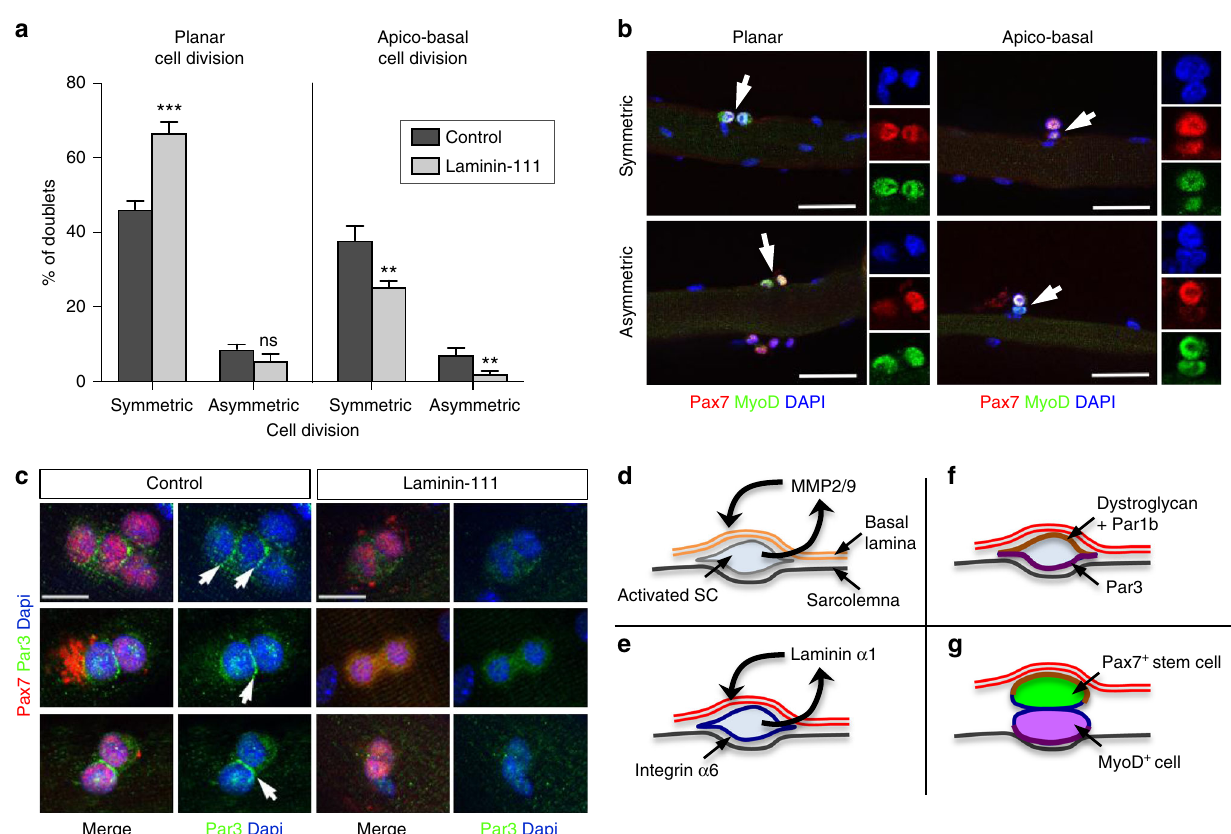
Fig. 8 Laminin-111 treatment alters SC cell polarity and stimulates planar cell division. a Quanti fi cation of planar and apico-basal cell divisions (symmetric and asymmetric) based on the expression of Pax7 and MyoD in T46 myo fi bers treated with PBS (control; dark gray) or laminin-111 (light gray). n = 3 with 50 – 82 doublets analyzed per culture. * P < 0.05, ** P < 0.01, *** P < 0.001 ( t -test). b Representative immuno fl uorescence images of planar and apico-basal cell divisions in T46 myo fi bers analyzed using antibodies against Pax7 (red) and MyoD (green). White arrows indicate cell doublets. Individual color channels are shown. Scale bar: 50 μ m c Representative immuno fl uorescence of Par3 (green) and Pax7 (red) in myo fi bers cultured for 46 h in in the presence of PBS (control) or laminin-111. Arrows indicate Par3 asymmetric distribution in control, but not in laminin-111 treated fi bers. The white star indicates background staining. Scale bar: 10 μ m. d – g Proposed model for laminin-111 control of SC self-renewal: d Upon activation, SCs upregulate MMP2 and MMP9 expression, leading to a local digestion of the laminin- α 2-containing basal lamina (double orange line) at the SC niche. e Simultaneously, SCs re-express laminin- α 1, which is secreted and deposited into the SC basal lamina (double red line), and the laminin- α 1 receptor, integrin- α 6 (blue line). f Laminin- α 1-mediated signaling initiates or maintains SC polarity through the asymmetric distribution of the basal determinant Par1b (brown) and the apical determinant Par3 (purple), leading to apico-basal cell polarity. g Apico-basal asymmetric cell division yields two distinct daughter cells, including a self- renewing SC associated with the basal lamina (Pax7 + in green) and a differentiating SC (MyoD + in